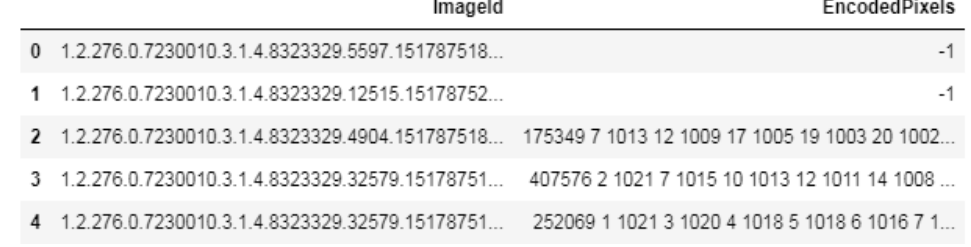
Figure 10. RLE file data for five images.